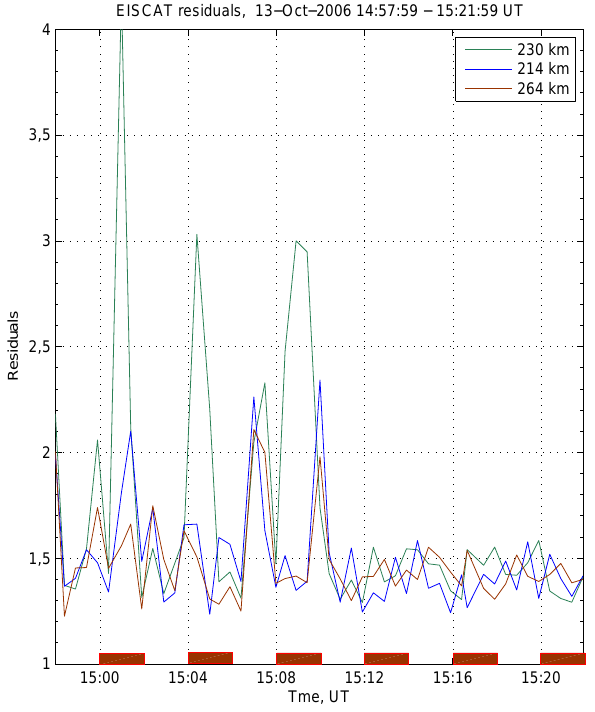
Fig. 8. Temporal variations of residuals of EISCAT UHF radar data at altitudes of 214, 230, and 264km. Fig. 8